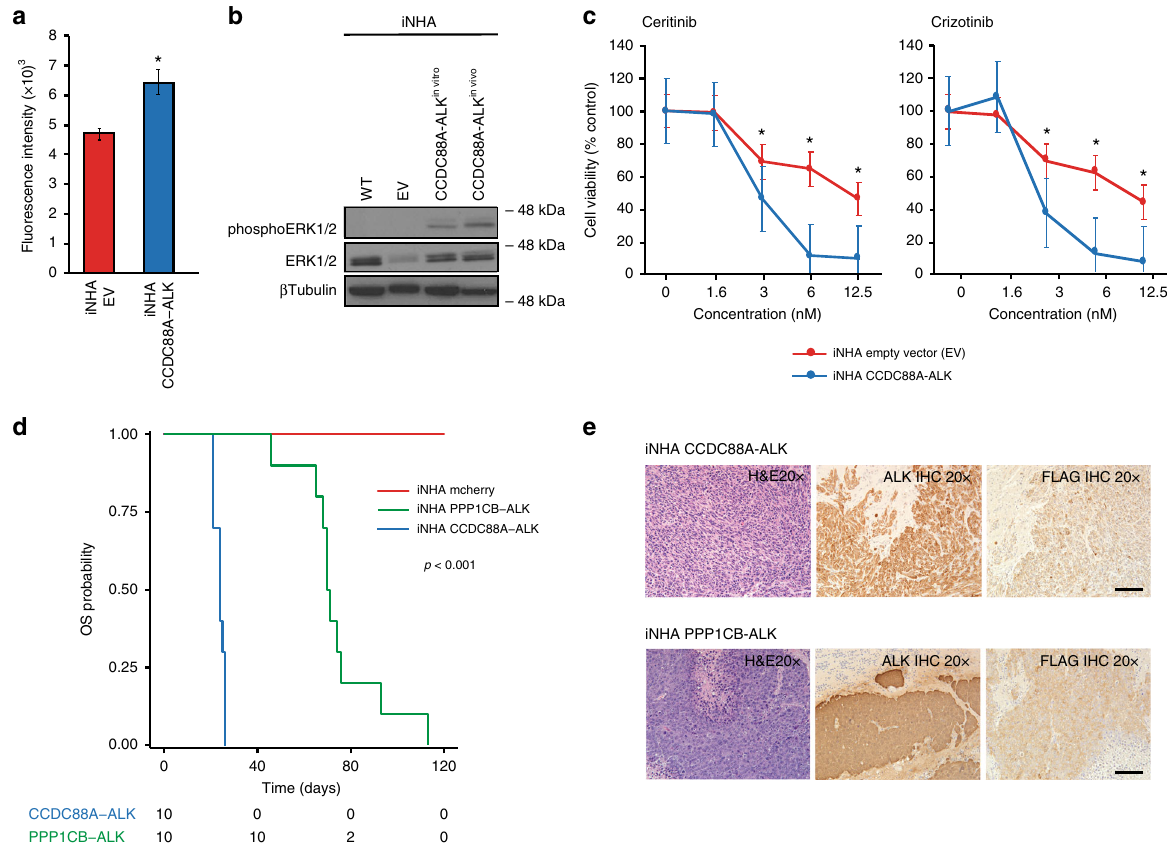
Fig. 3 ALK fusions are tumorigenic and susceptible to targeted agents. a Proliferation of iNHA cells overexpressing CCDC88A-ALK compared with iNHA with empty vector (EV). Experiments were conducted in triplicates in four biological replicates ( n = 12). Data are represented as mean with SEM, * p < 0.05, paired t test. b Western blot for total and phosphorylated ERK1/2 indicative of MAPK pathway activation in iNHA cells overexpressing CCDC88A-ALK as compared with iNHA EV. c Dose-response curves of iNHA expressing CCDC88A-ALK versus EV upon treatment with ALK inhibitors Ceritinib and Crizotinib. Experiments were conducted in triplicates in two biological replicates (n = 6). Data are represented as mean with SEM, * p < 0.05, paired t test. d In vivo orthotopic xenografts of iNHAs overexpressing CCDC88A-ALK and PPP1CB-ALK resulted in tumor formation with 100% penetrance, p value calculated using the log-rank test. e Hematoxylin and eosin (H&E) and immunohistochemistry (IHC) showing overexpression of FLAG and ALK in the intracranial xenografts. Images are taken at 20x magni fi cation, scale bar = 100 μ m. iNHA: immortalized normal human astrocytes, nM: nanomolar,